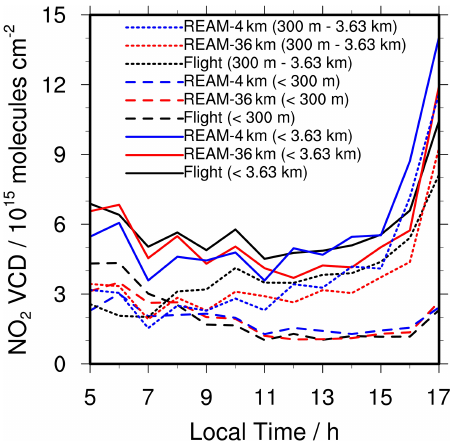
Figure 11. Weekday hourly variations in NO 2 VCDs at dif- ferent height (a.g.l.) bins ( < 3.63kma . g . l . , < 300ma . g . l . , and 300m ∼ 3.63kma . g . l . ) based on P-3B-aircraft-derived datasets and the 36 and 4km REAM results. “Flight” denotes P-3B-aircraft- derived NO 2 VCDs, “REAM-36km” denotes coincident 36km REAM-simulated VCDs, and “REAM-4km” denotes coincident 4km REAM-simulated